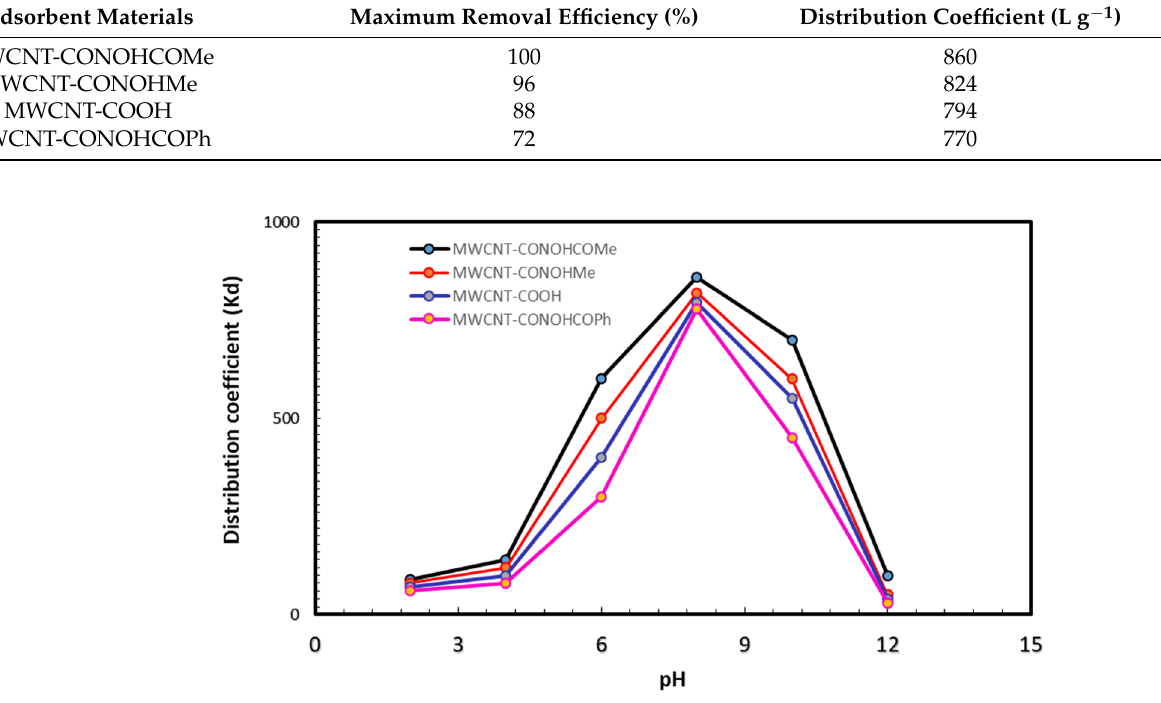
Figure 8. Effect of pH on the distribution coefficient for Pb(II) adsorbed onto different prepared adsorbent materials. Table 2. The prepared adsorbent materials’ performance evaluations for removing Pb(II) at 8 pH and a 100 mgL − 1 metal starting concentration.